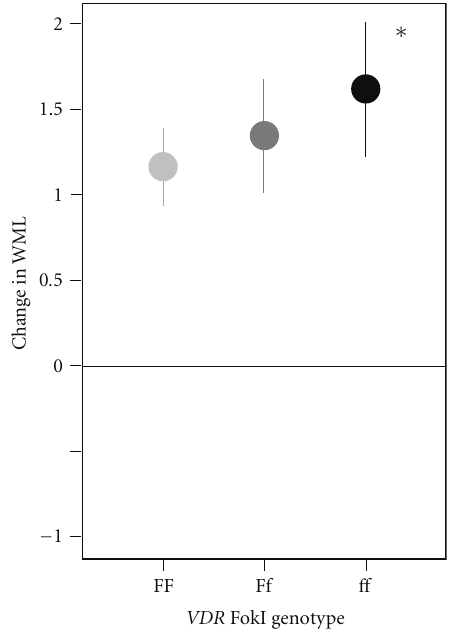
Figure 5: Change in WML grade score by VDR FokI genotype. The light gray, dark gray, and black lines are for groups with the FF, Ff, and ff genotypes, respectively. The asterisk indicates that the estimated change in WML scores for genotype was significantly di ff erent from the FF